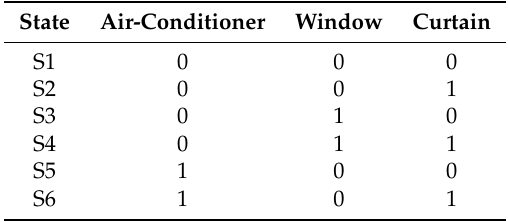
Table 2. States of the